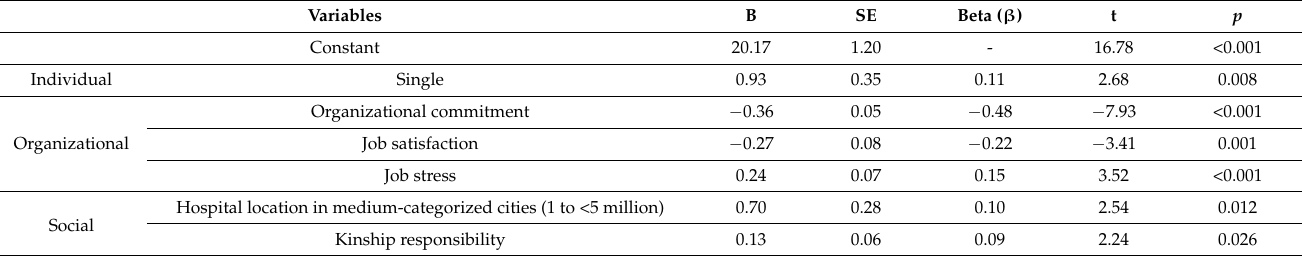
Table 3. Multiple linear regression results ( N =